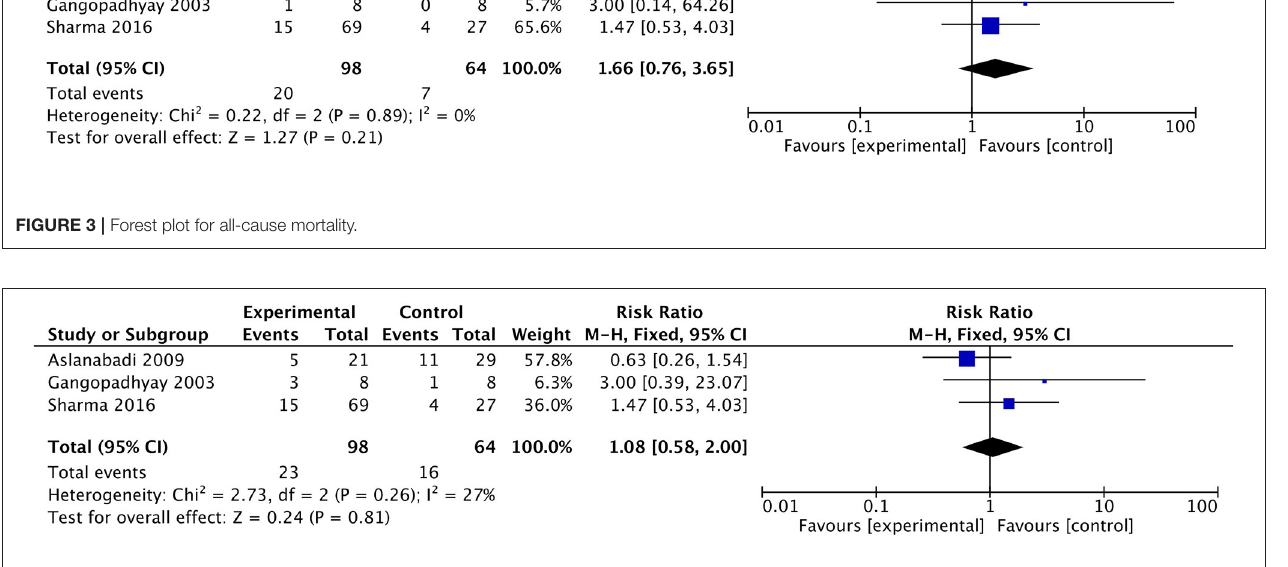
FIGURE 4 | Forest plot for serious adverse events.